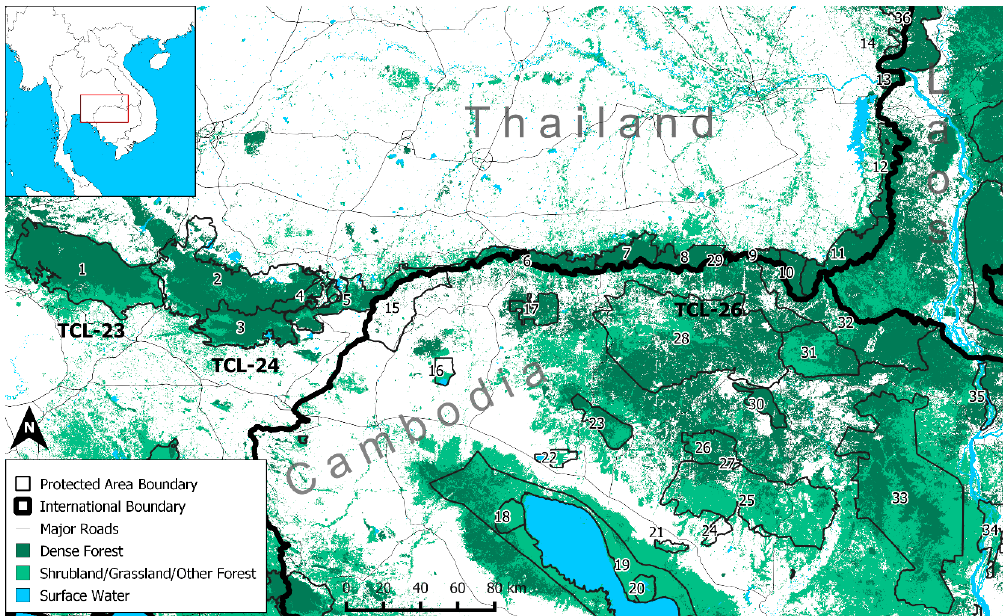
Figure 1. Study area for connectivity analysis. Protected areas were generated from UNEP-WCMC and IUCN [35]; a full listing of names can be found in Supplementary Materials 1. Forest cover was generated from 2018 SERVIR–Mekong Regional Land Cover Monitoring System (RLCMS; [36]) reclassed into dense forest (including Forest, Evergreen Forest, Flooded Forest, and Mixed Forest), and Shrubland / Grassland / Other Forest (including Shrubland, Grassland, Wetlands and Orchard / Plantation). Major roads were derived from OpenStreetMap [37]. The eastern section (TCL-24) of the Dong Phayayen-Khao Yai forest complex (2–5) acts as the source site for our simulations.